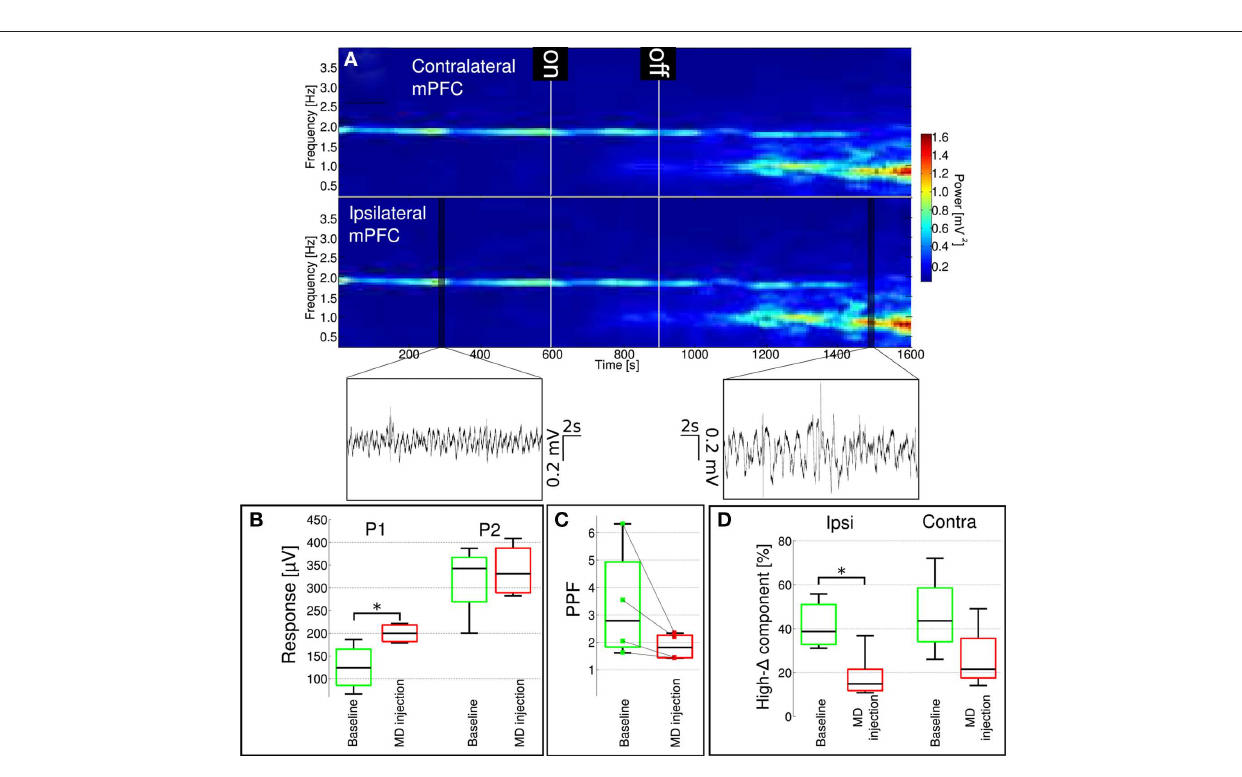
Figure 7 | Localized administration of MK-801 into the mediodorsal nucleus of the thalamus results in changes similar to those observed following systemic drug administration. (A) Spectrogram of contralateral (upper) and ipsilateral (lower) mPFC LFP. Microdialysis pump was turned on after 10 min baseline recording for 5 min. Onset of activity similar to i.v. MK‑801 injection was shortly after the pump was turned off in this particular experiment. Insets show characteristic LFP traces from highlighted regions of the ipsilateral